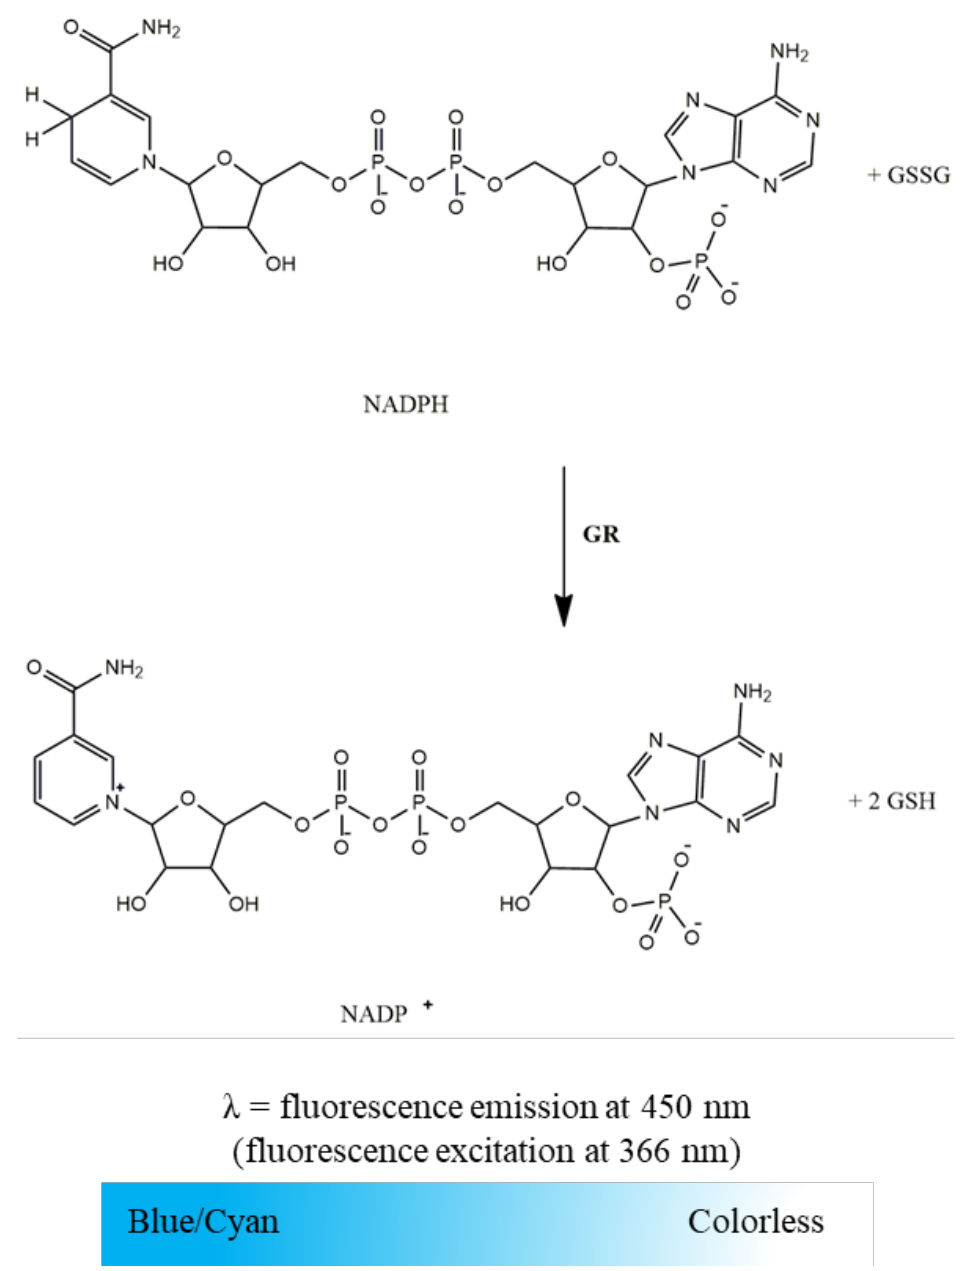
Figure 4. Oxidation of NADPH to NADP + with reduction of GSSG to GSH by GR. The NADPH oxidation intensity is measured at 450 nm (setting excitation at 366 nm). Table 2. Conditions and flow setup for GR activity assay.